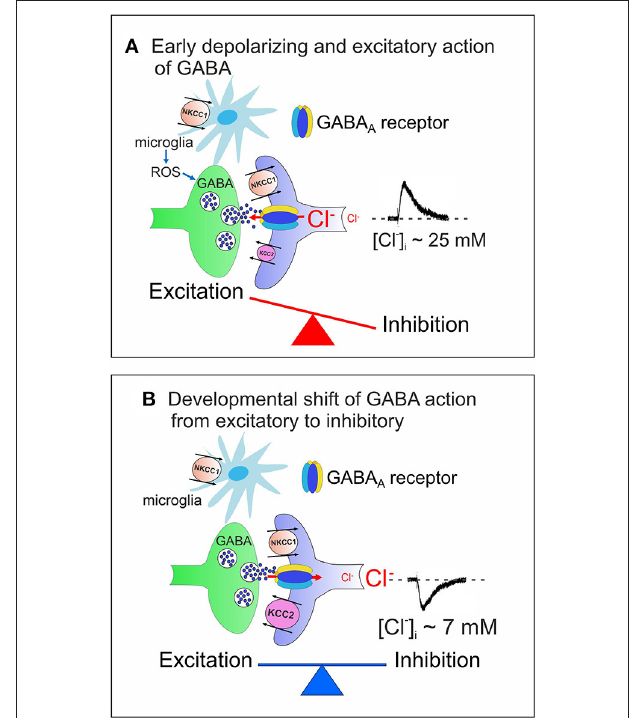
FIGURE 1 | Cation chloride co-transporters contribute to maintain a proper E/I balance in neuronal circuits. (A) Early in postnatal life, in rodent’s hippocampus, GABA, released from GABAergic interneurons, exerts via GABA A receptors a depolarizing, excitatory action in targeted cells by an outwardly directed flux of Cl − . High [Cl − ] I results from the differential temporal expression of Cl − importer and exporter NKCC1 and KCC2, respectively, and accumulation of Cl − inside via NKCC1. Early in postnatal life, GABAergic transmission is controlled also by microglia via ROS. The early depolarizing and excitatory action of GABA, which leads to E/I unbalance, is instrumental in stimulating synaptogenesis and in shaping early neuronal circuits. (B) In juvenile and adult animals, the upregulated expression of KCC2 contributes to maintain a low [Cl − ] I , responsible for the hyperpolarizing action of GABA and for preserving a proper E/I balance in neuronal circuits. In (A,B) both pre- (GABAergic interneurons, green) and post-synaptic (targeted cells, violet) elements are represented. Red arrows indicate the direction of Cl − flux through GABA A receptor